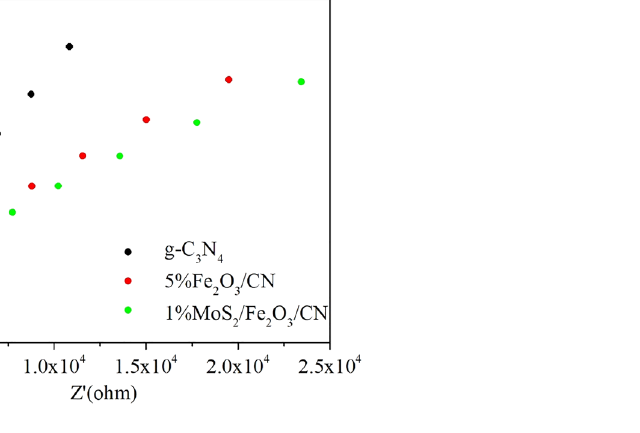
Figure 10. Electrochemical impedance spectra of